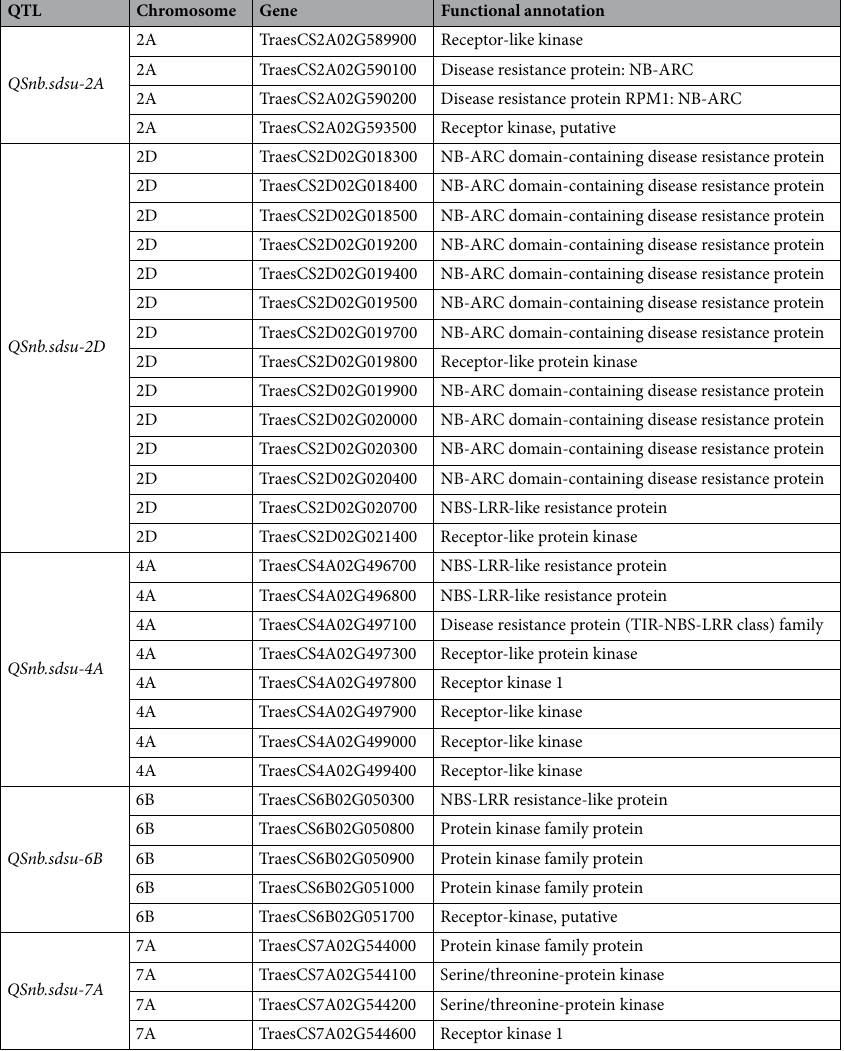
Table 3. Summary of the candidate genes in the identified QTL regions. Gene IDs and functional annotation are based on IWGSC CS RefSeq v 1.1